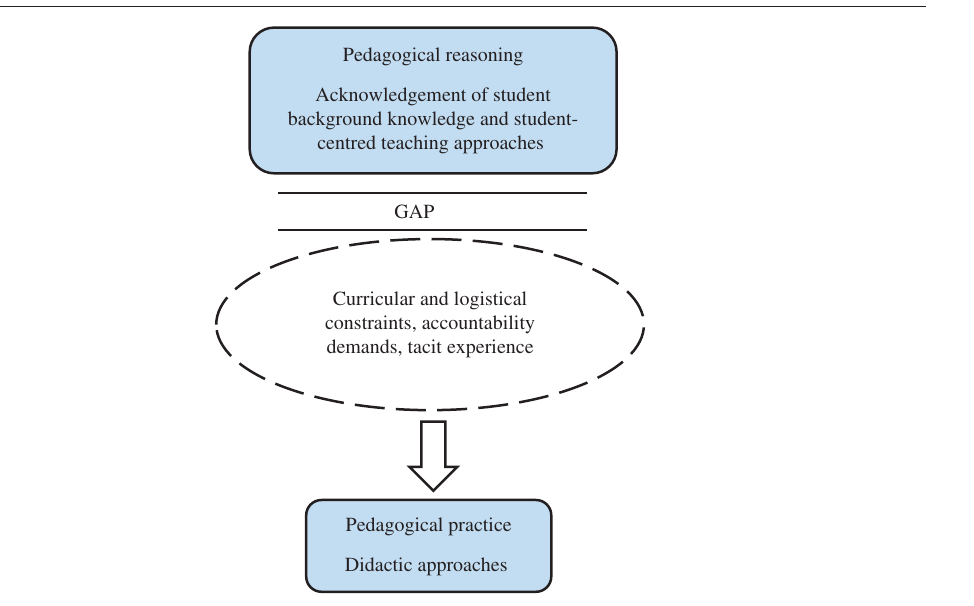
Figure 2: Revised relationship between teacher reasoning and